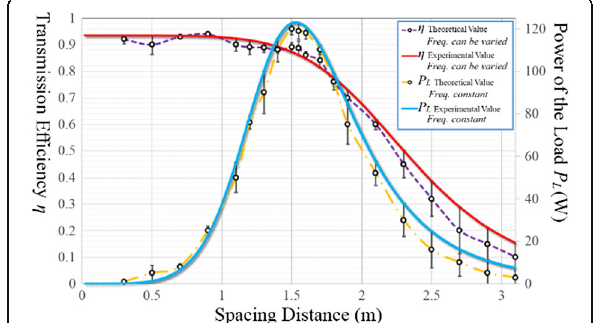
Fig. 6 Transmission efficiency η and power of the load P L as a function of spacing distance. Transmission efficiency η and power of the load P L as a function of spacing distance is shown in this figure. The transmission efficiency η curves of theoretical value and experimental value when the frequency can be varied decay with the increase of distance. When the frequency is constant, there is a peak value of the load P L . The curve shows that the error between theoretical calculation and actual measurement is relatively